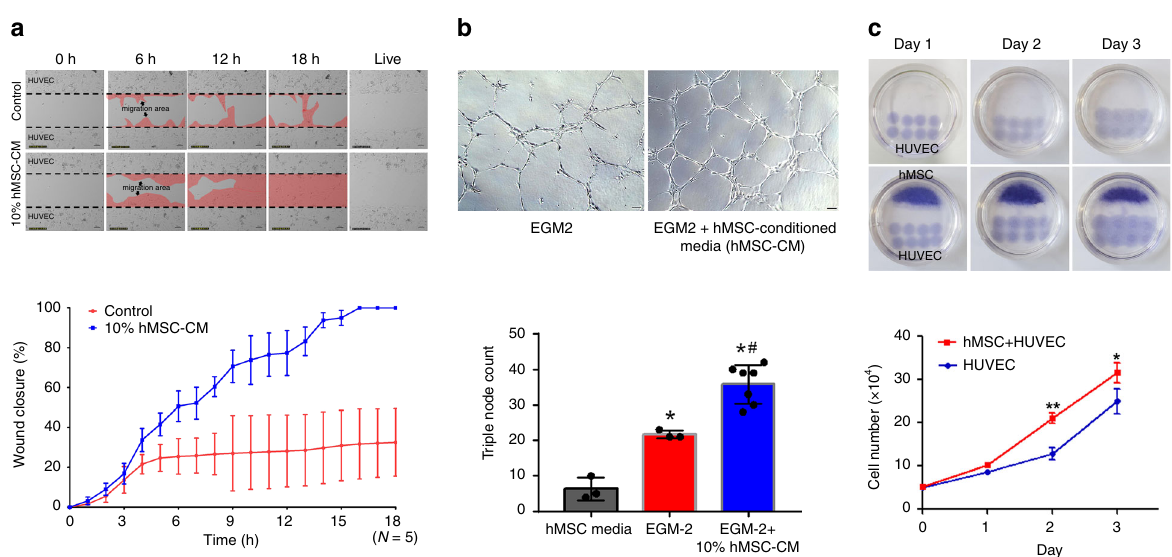
Fig. 5 Secreted factors from hMSCs promote endothelial cell migration and vasculogenic potential. a Endothelial cell-migration assay. The HUVEC were incubated with 10% conditioned media harvested from hMSC cultures (hMSC-CM) or control media to evaluate the migration capability. Representative Images under an inverted microscope and quanti fi cation summary. The data are represented as mean ± SEM. * p < 0.05 compared with control group; n = 5 biologically independent samples per group. T test was used for statistical analyses. b Matrigel plug assay. The 10% hMSC-CM was treated to HUVEC on matrigel to examine the vasculogenic potential. Representative images of tubes formed on Matrigel and quanti fi cation summary. The data are represented as mean ± SEM. * p < 0.05 compared with hMSC basal media, # p < 0.05 compared with EGM2 group; n = 3 biologically independent samples per group. One-way ANOVA was used for statistical analyses. c Increased proliferation of HUVEC when they were co-cultured with hMSCs. Representative images of co-cultures of hMSCs and HUVEC and quanti fi cation summary. The data are represented as mean ± SEM. * p < 0.05 and ** p < 0.01 compared with HUVEC only group; n = 3 biologically independent samples per group. T test was used for statistical analyses